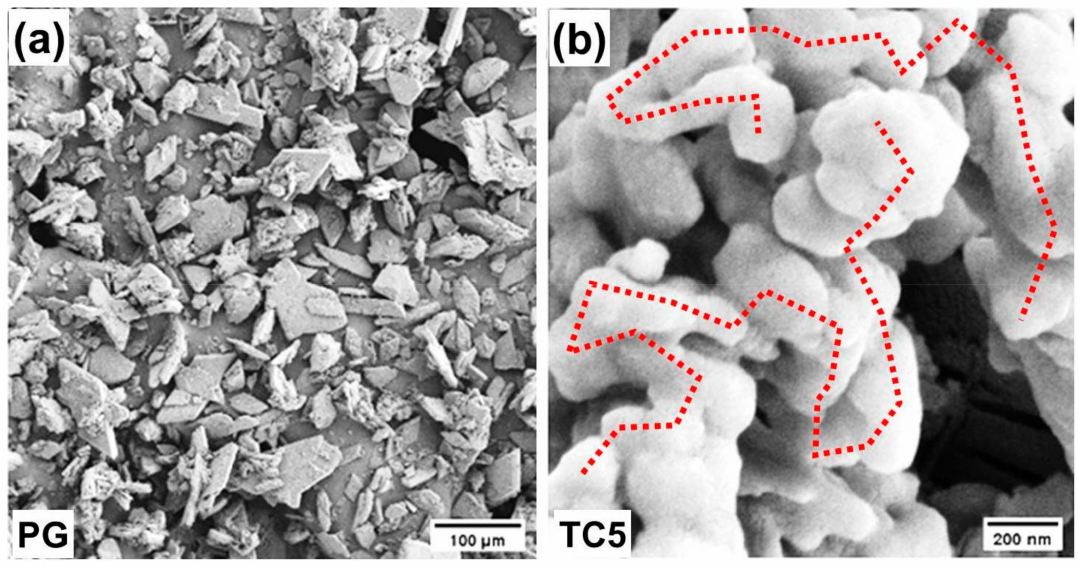
Figure A1. Morphology of ( a ) PG and ( b )